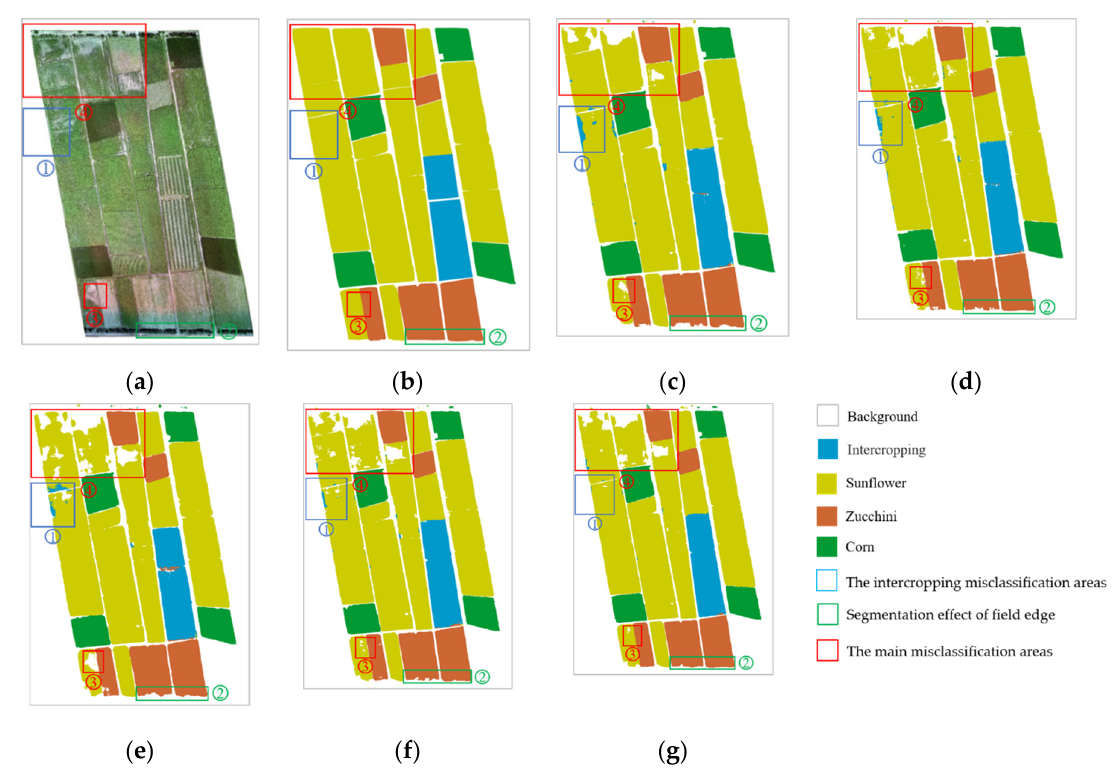
Figure 10. Comparison of classification results of different methods on test area 2. ( a ) Orthoimage, ( b ) ground truth, ( c ) PSPNet, ( d ) DeepLabV3+, ( e ) DNLNet, ( f ) OCRNet, and ( g ) the proposed method.